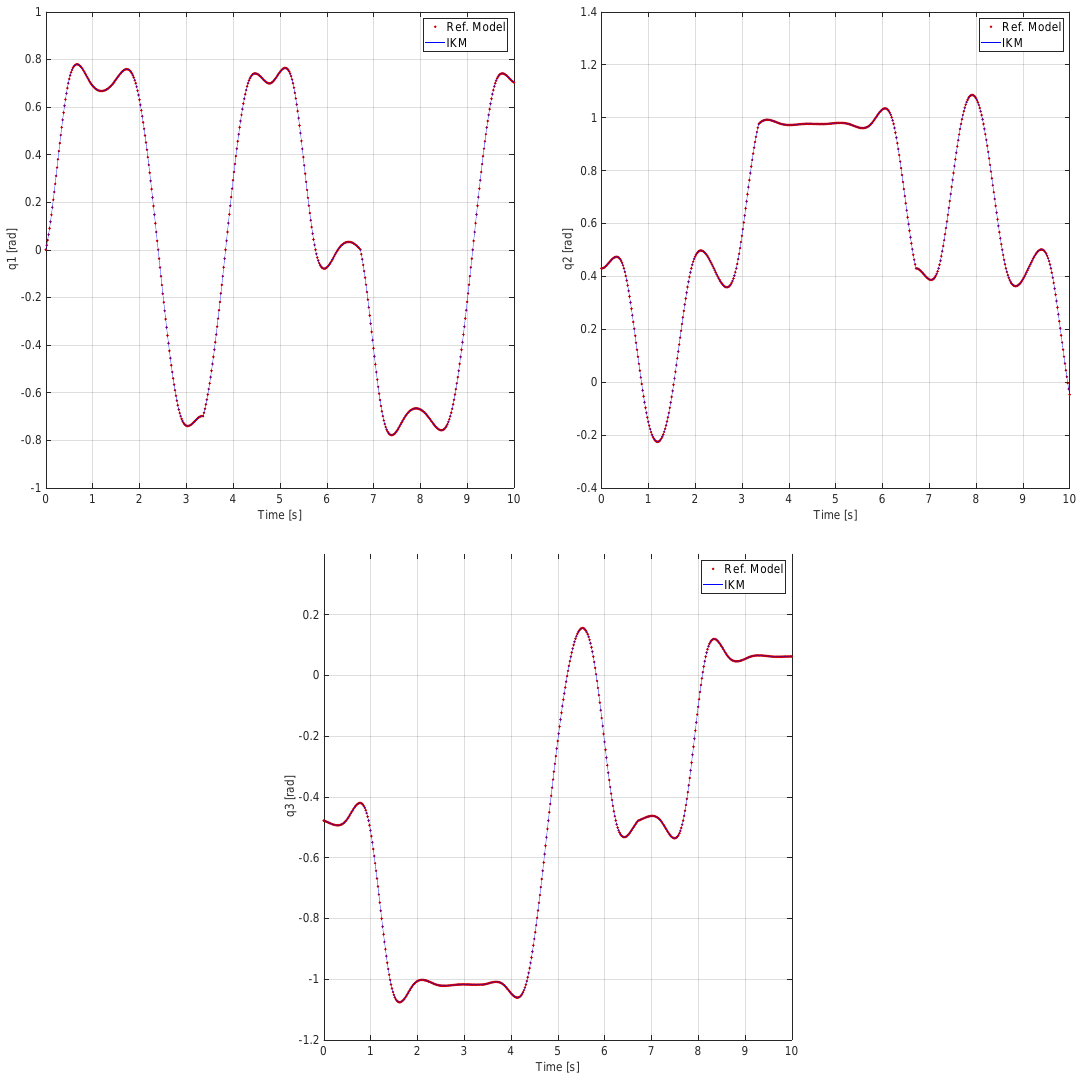
Figure 11. Trajectory tracking analysis for the hexapod’s IKM. The red dots represent the outputs of the reference model, for each of the leg’s DoFs, when it is supplied with the predetermined trajectory, while the continuous blue lines are the IKM’s outputs for that same trajectory. The upper left figure presents the computed outputs for the first DoF ( q 1 ), the upper right one corresponds to the second ( q 2 ), while the bottom figure is the one for the third DoF ( q 3 ). The data show that the IKM’s outputs follow the ones of the reference model, with high accuracy and a negligible error along all the desired trajectory, in all three